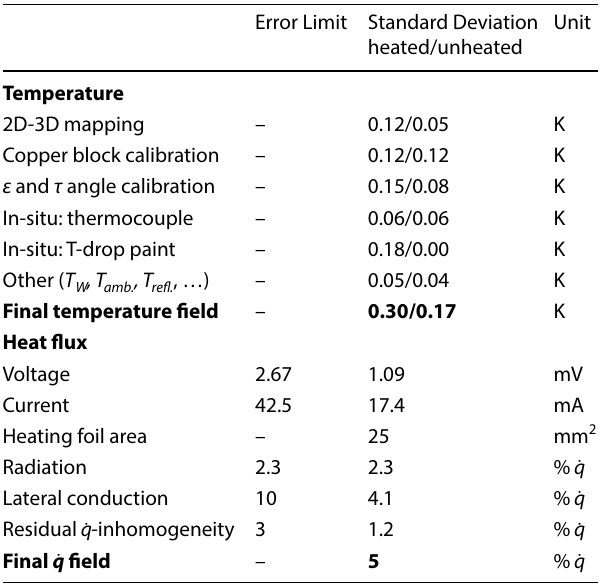
Table 2 Breakdown of measurement uncertainty in the final tem- perature and heat flux fields